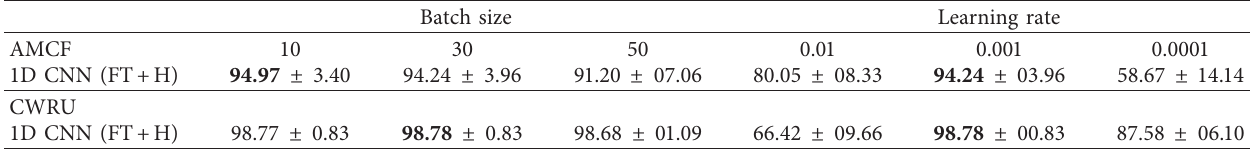
Table 4: Accuracy results of 1D CNN on AMCF and CWRU datasets, using different batch sizes and learning rates.